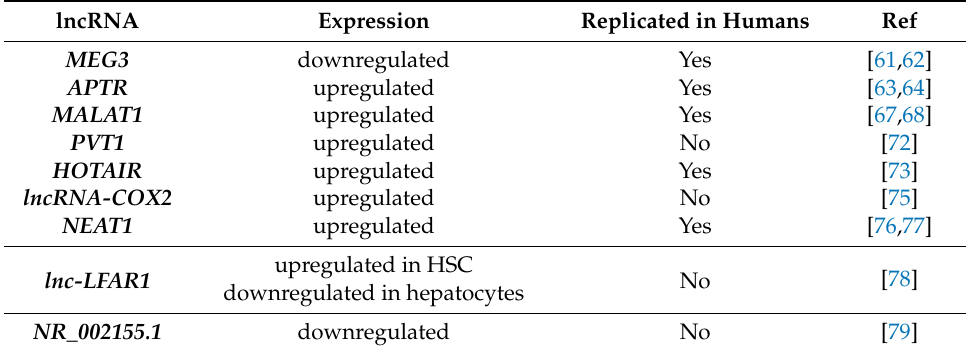
Table 1. Summary of long non-coding RNAs (lncRNAs) identified in animal